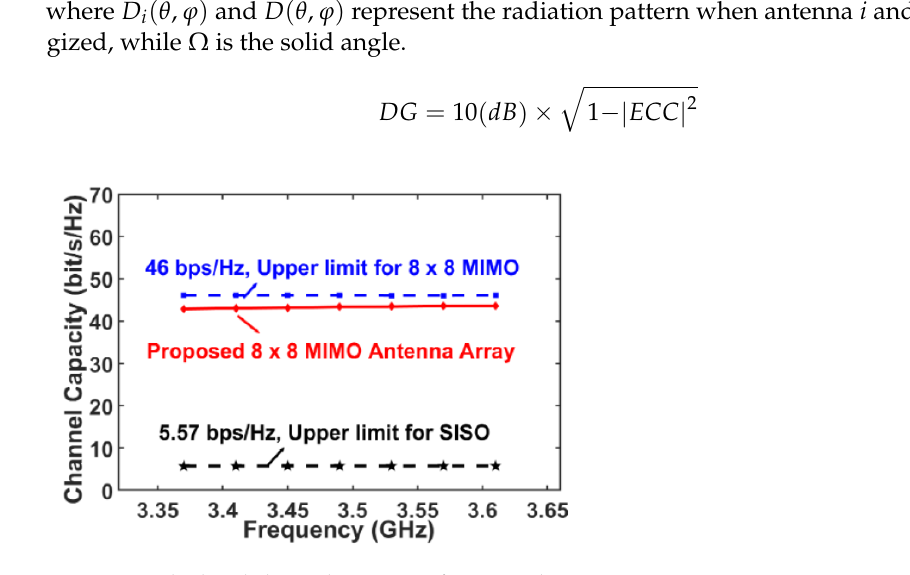
Figure 9. Calculated channel capacity of proposed system.